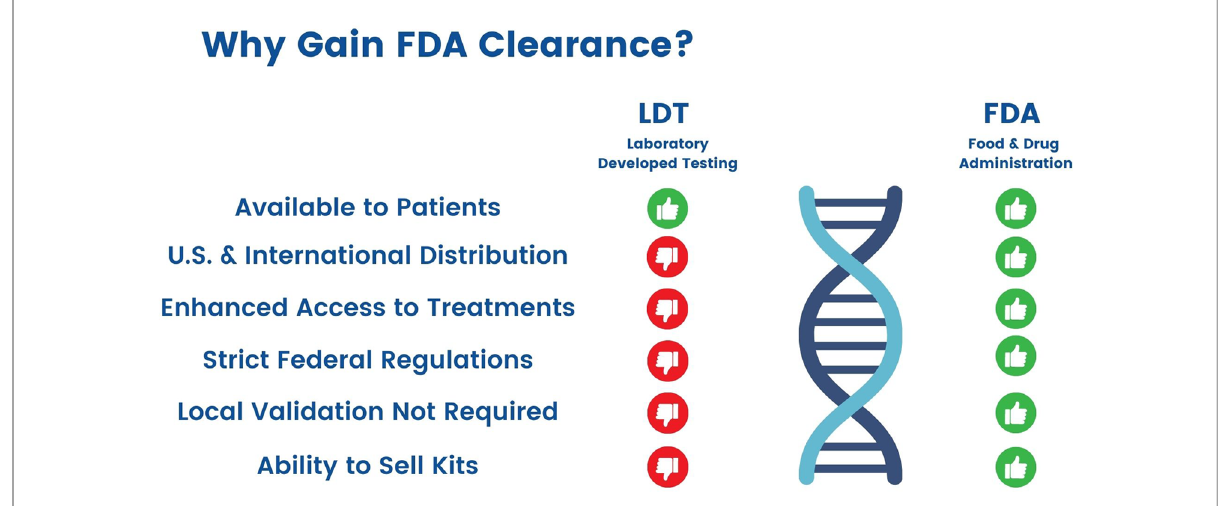
FIGURE 4 Differences between Laboratory Developed Tests and FDA-Cleared Tests.